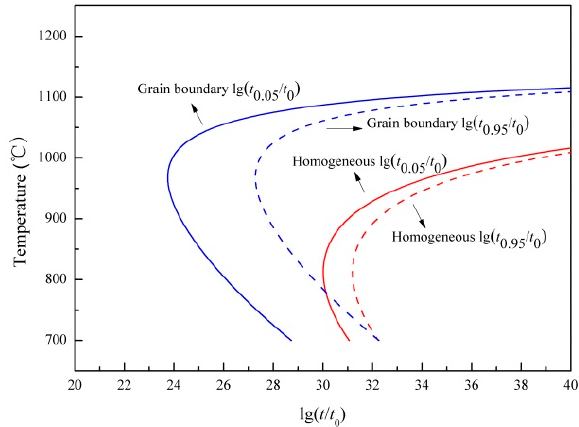
Figure 16. Calculated precipitation ‐ time–temperature (PTT) diagrams of microalloyed steel.